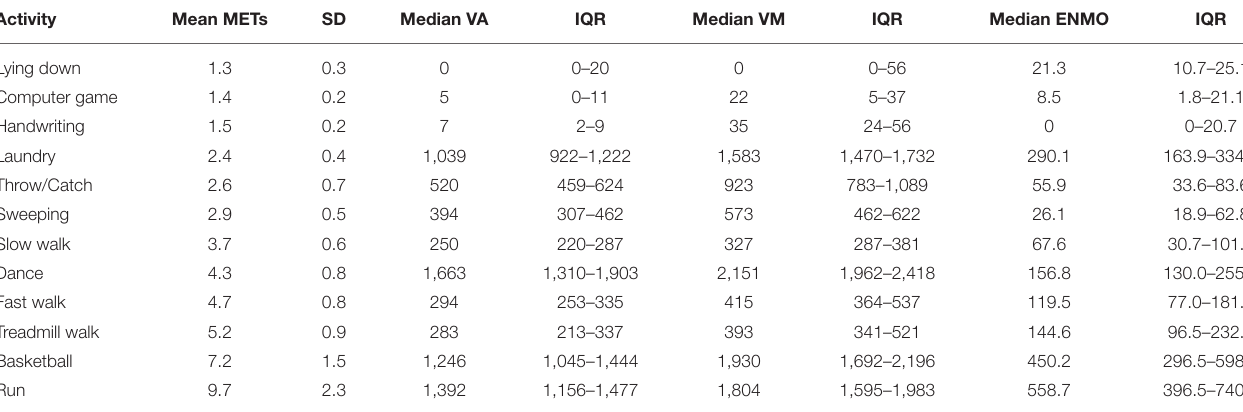
TABLE 3 | Descriptive statistics for Youth METs, vertical axis (VA) counts, vector magnitude (VM) counts, and ENMO for each activity trial.